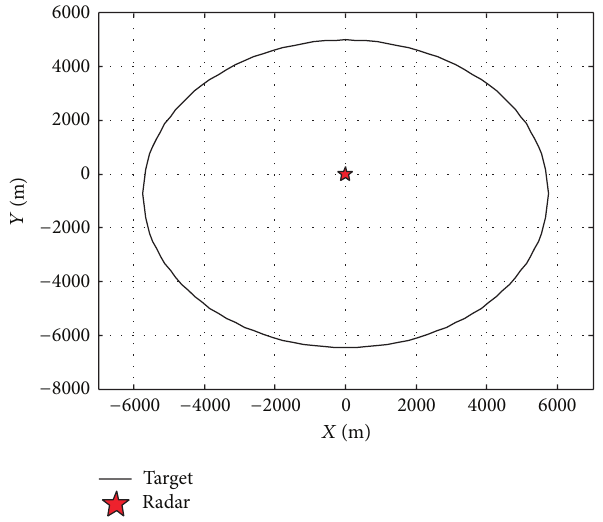
Figure 5: Aircraft trajectory and radar location.